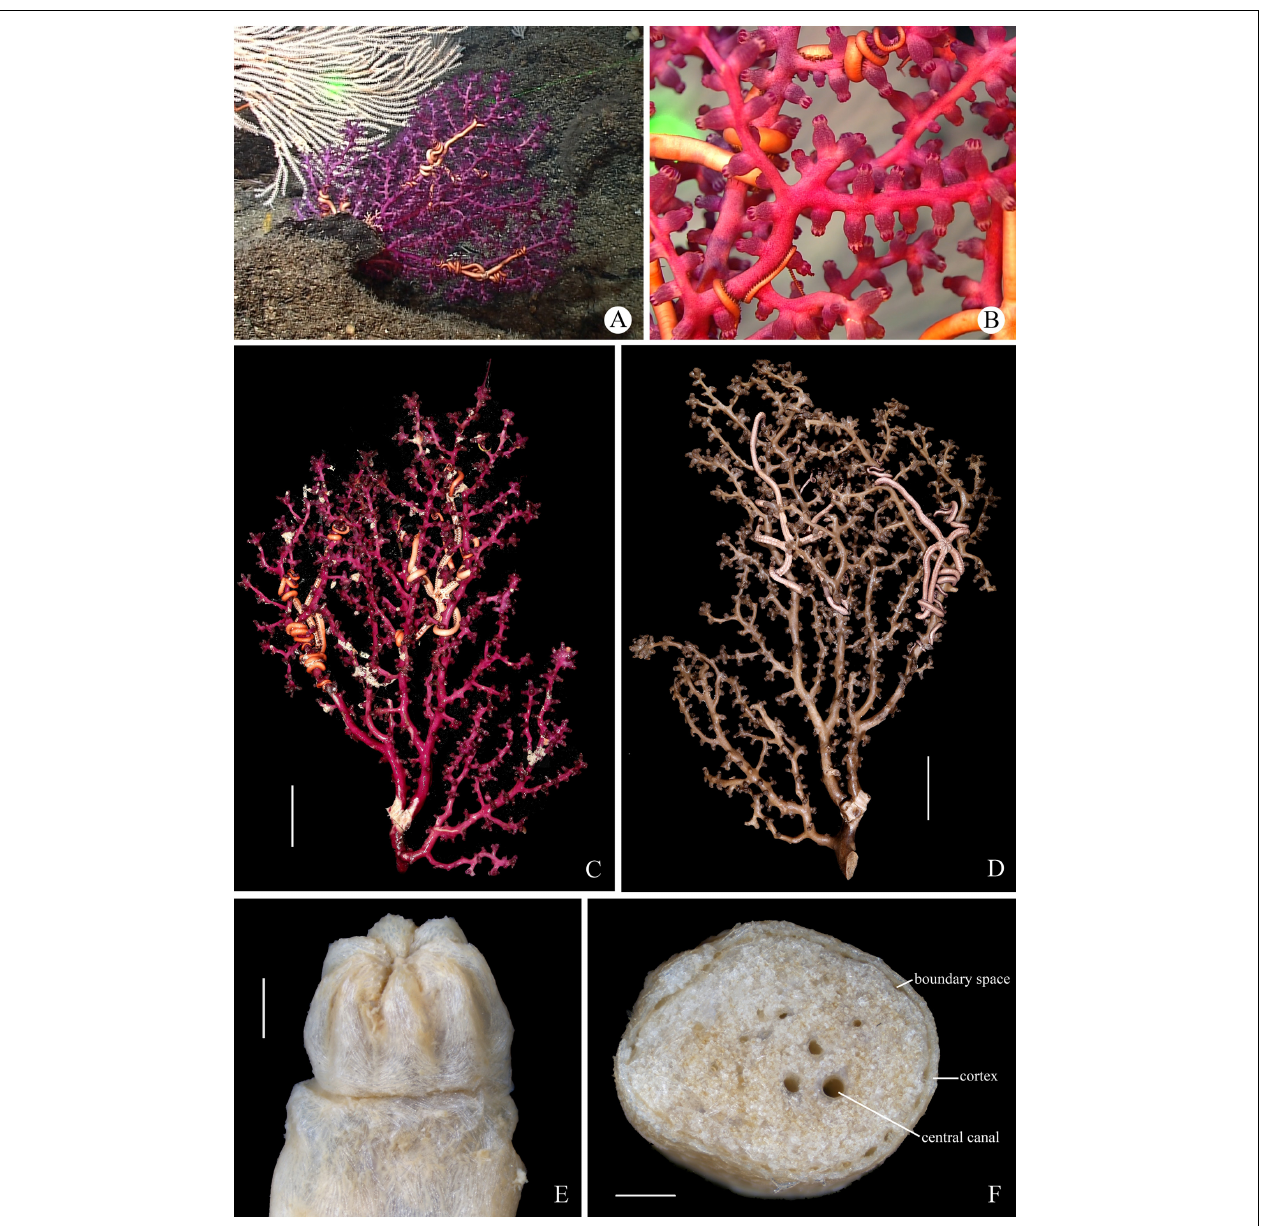
FIGURE 11 | The specimen MBM286392 of Victorgorgia eminens Moore et al., 2017. (A) In situ . Laser dots spaced at 33 cm used for measuring dimensions. (B) Close view in situ , showing expanded polyps. (C) The freshly collected specimen, photographed by Shaoqing Wang. (D) The preserved specimen. (E) Polyp head in lateral view. (F) Cross-section of terminal medulla. Scale bars = 5 cm (C,D) , and 1 mm (E,F)